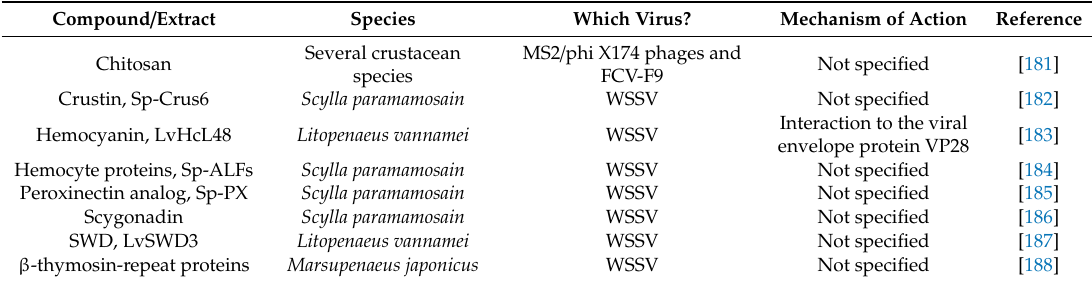
Table 9. The table report antiviral compounds / extracts from crustaceans. FCV-F9, Feline Calicivirus F9; WSSV, White Spot Syndrome virus; VP28, viral envelope protein.